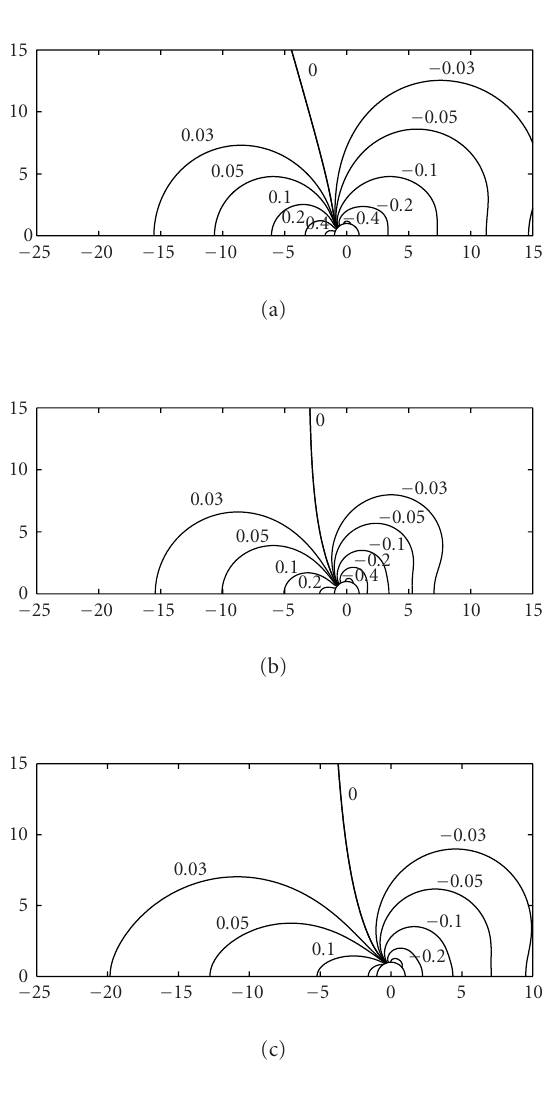
Figure 4.11 . Pressure fields for the flow with Re = 40. (a) N = 0, (b) N = 1, and (c) N = 12.